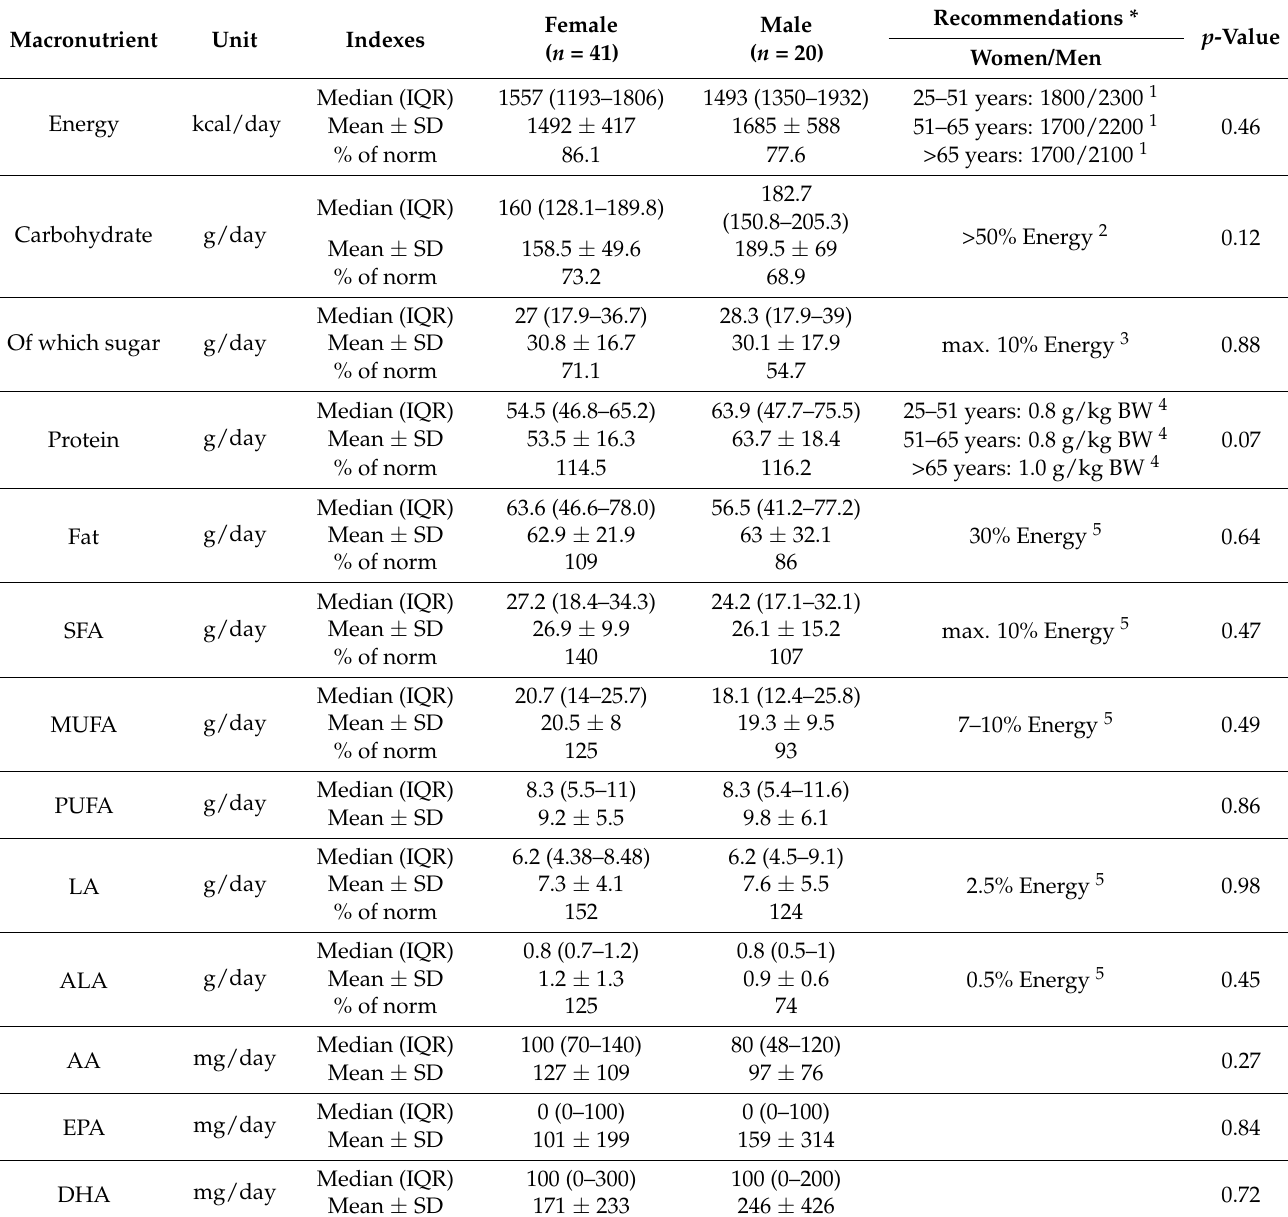
Table 3. Energy and macronutrient intake in patients with RA ( n =